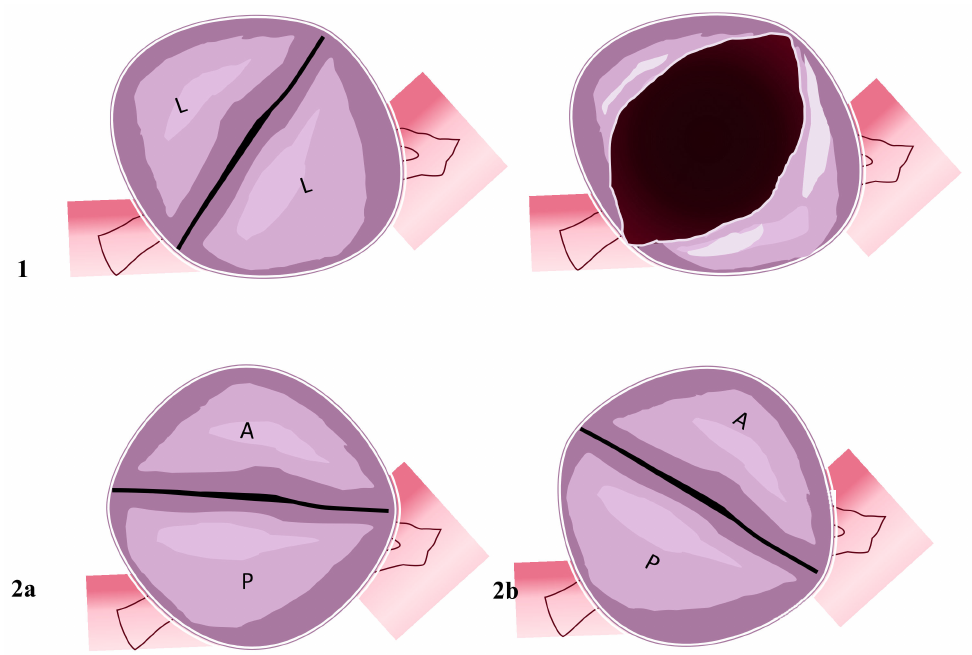
Figure 2. Two-sinus bicuspid aortic valve. Figure represents two cusps’ non-fusion patterns seen in the short heart axis. Aortic valves have two sinuses with two leaflets non-derived from fusion mechanisms. ( 1 ) Coronary arteries originate from the two sinuses with two lateral leaflets. The opened valve in systole phase has the oval-ball image. ( 2a ) In this position, coronary arteries originate from the anterior sinus (right coronary artery) and posterior sinus (common left stem). ( 2b ) Right coronary artery and common left stem both originate from anterior sinus. Abbreviations; A, anterior; L, lateral P,